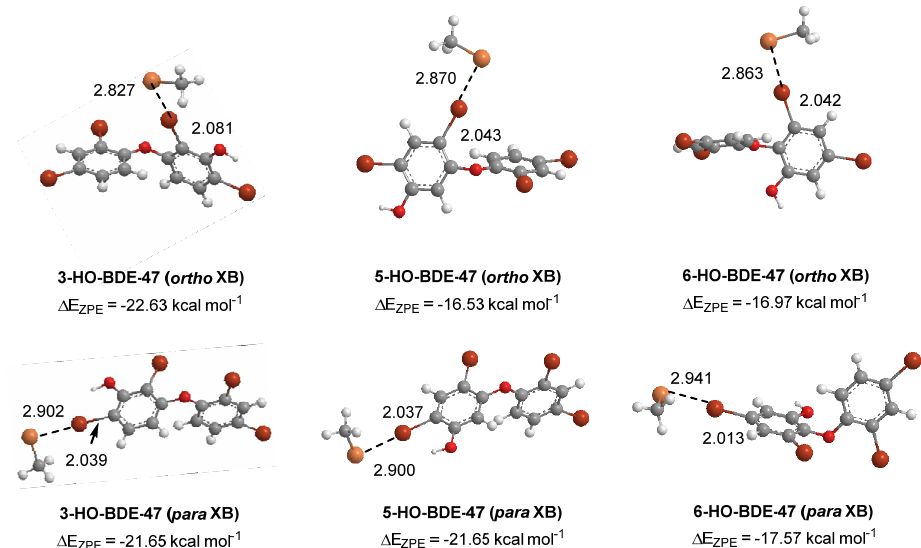
Figure 6. Sample structures of PBDEs and the hydroxylated metabolites of BDE-47.